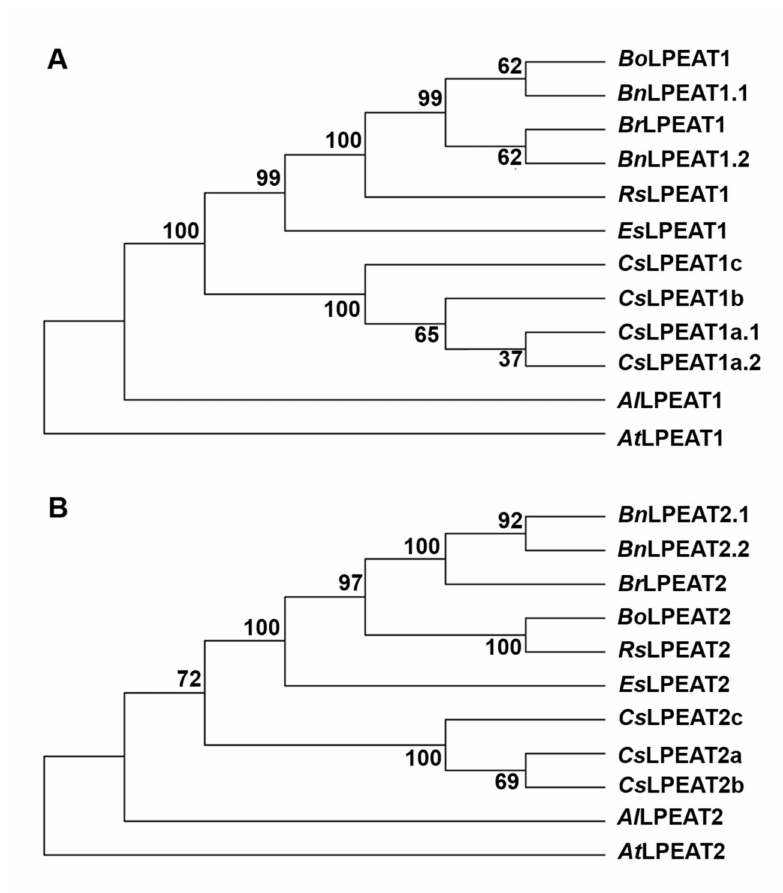
Figure 4. Predicted evolutionary relations between Brassicaceae family LPEATs. Cs LPEAT1 isoforms and other LPEAT1 plant amino acid sequences are analyzed in panel ( A ), while Cs LPEAT2 isoforms and other LPEAT2 plant amino acid sequences are analyzed in panel ( B ). Both trees are rooted in the corresponding Arabidopsis thaliana (At) orthologues ( At LPEAT1 for panel A, At LPEAT2 for panel ( B )). All gene denotations and their species of origin are elaborated on in Supplementary Table